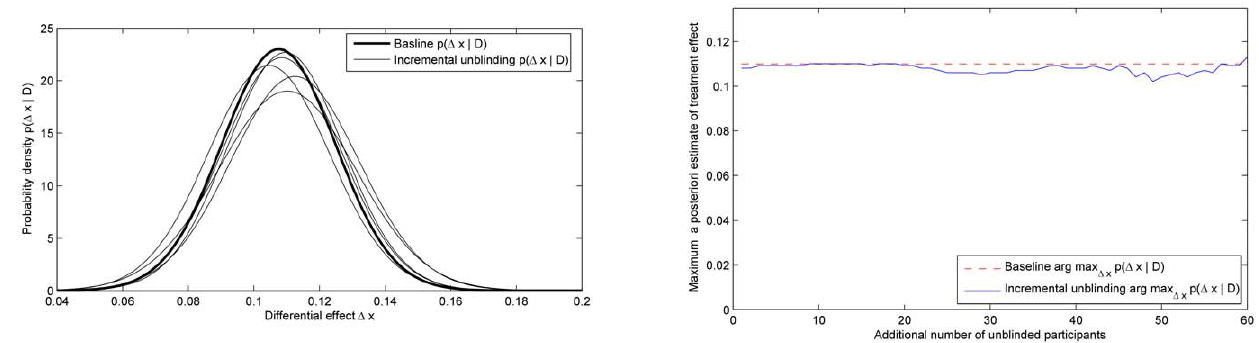
Figure 7. Experiment 3. (a) Initial posterior (bold line) and the sequence of posteriors as ‘‘don’t know’’ responders in the treatment group are progressively unblinded. Each next posterior plot corresponds to additional 10 ‘‘don’t know’’ respondents who become members of the sub-group which correctly identified their group membership. (b) The maximum a posteriori estimate of the treatment effectiveness as the participants assigned to the treatment group are progressively unblinded. Observe the robustness of the proposed approach, witnessed by little effect that unblinding has on the estimate (standard deviation of the maximum a posteriori estimate: 0.0054); compare with Figure 8.